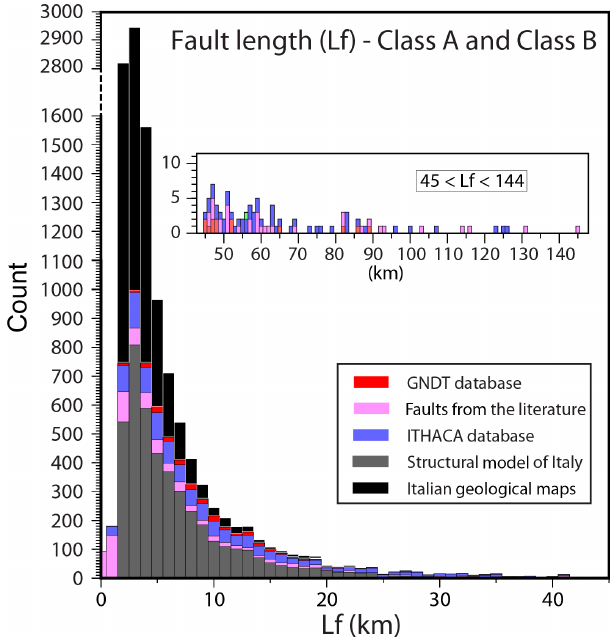
Figure 4. Histogram of fault lengths ( L f ) derived from all analysed datasets. Inset shows the same histogram for fault lengths ≥